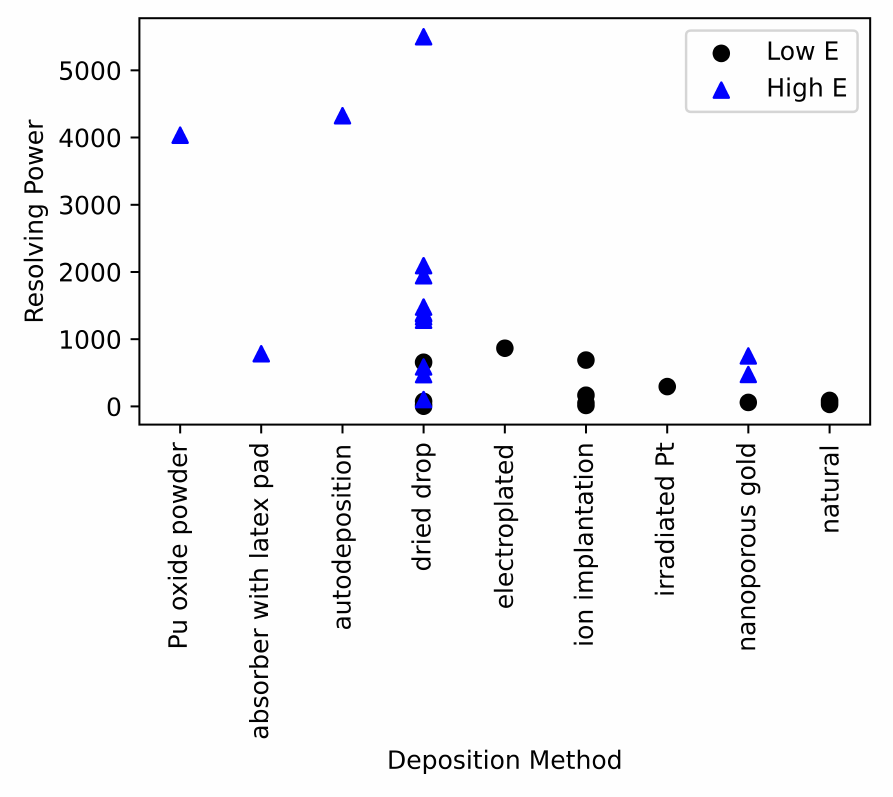
Figure 7. Detector resolving power as a function of deposition